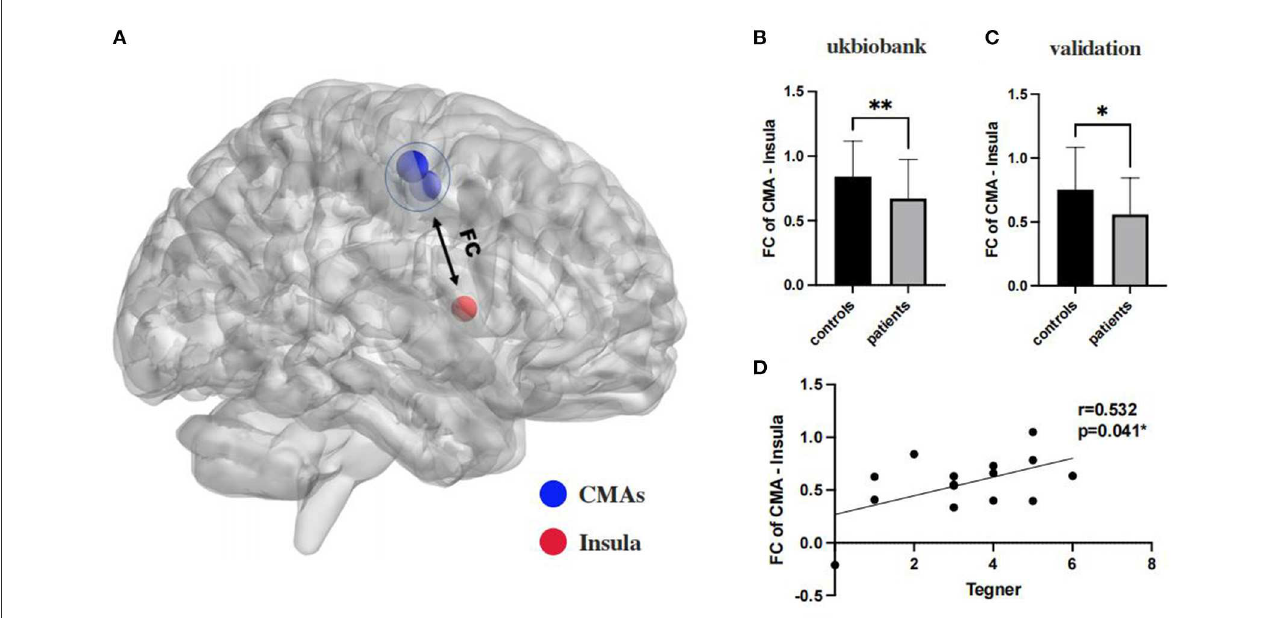
FIGURE3 (A) The insula and CMAs ROIs in global brain as sphere, in which blue color was ROIs of CMAs, and for red color was ROIs of Insula; (B, C) : the functional connectivity between CMA and insula are significant on a corrected cluster level in ukbiobank ( p = 0.005) and clinical validation ( p = 0.049) both; (D) : functional connectivity of CMA and insulation significantly correlated with Tegner scores ( r = 0.532, p = 0.041). **Significant ( p < 0.001); *Significant ( p <